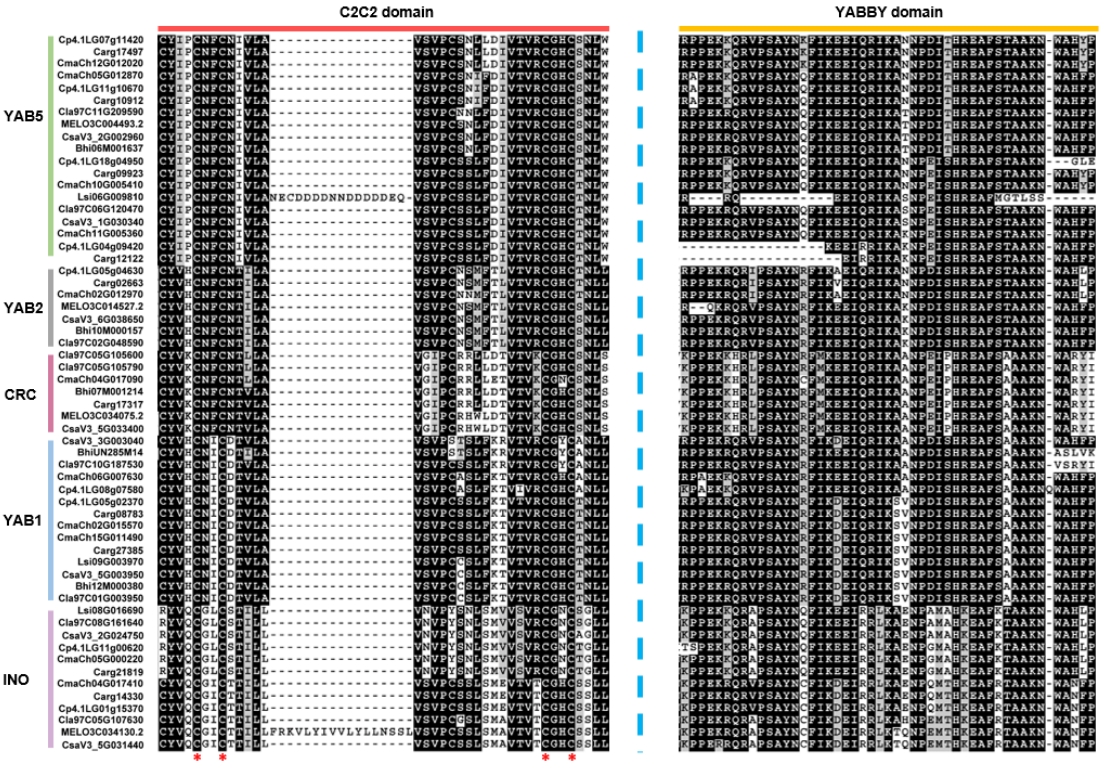
Figure 4. The conserved C2C2 domain and YABBY domain of 59 YABBY proteins from eight cucurbit species. The typical amino acid residues within C2C2 domain are indicated with red asterisks.